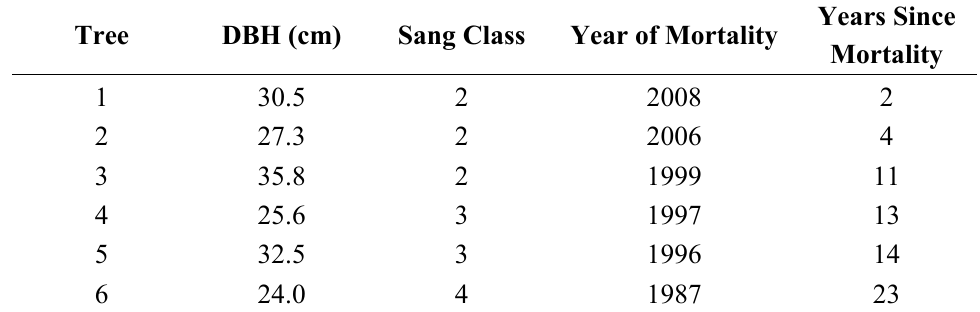
Table 3. Diameter at 1.4 m (DBH), snag class, year of mortality and years since mortality (calculated from 2010) of six snag trees at Wompatuck State Park, Massachusetts. Tree DBH (cm) Sang Class Year of Mortality